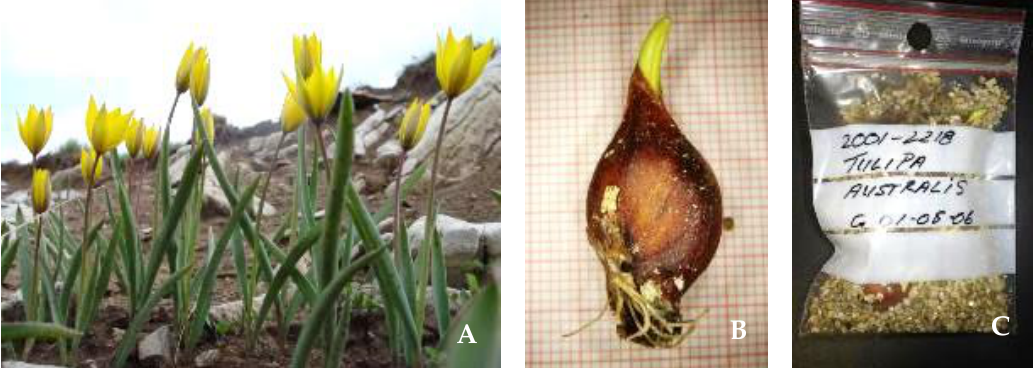
Figure 3. ( A ) Wild-growing individuals of the Mediterranean Tulipa australis at the summit area of Mt Vermion, Northern Greece; ( B ) underground individual bulb; and ( C ) repatriated well-documented bulbs of the same species from the Gothenburg Botanical Garden, Sweden that were originally collected close to the summit area of Mt Vourinos, northern Greece in 2001.